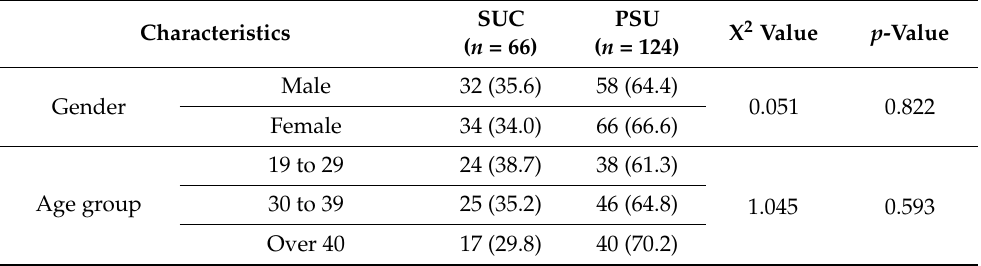
Table 1. Demographic data of SUC and